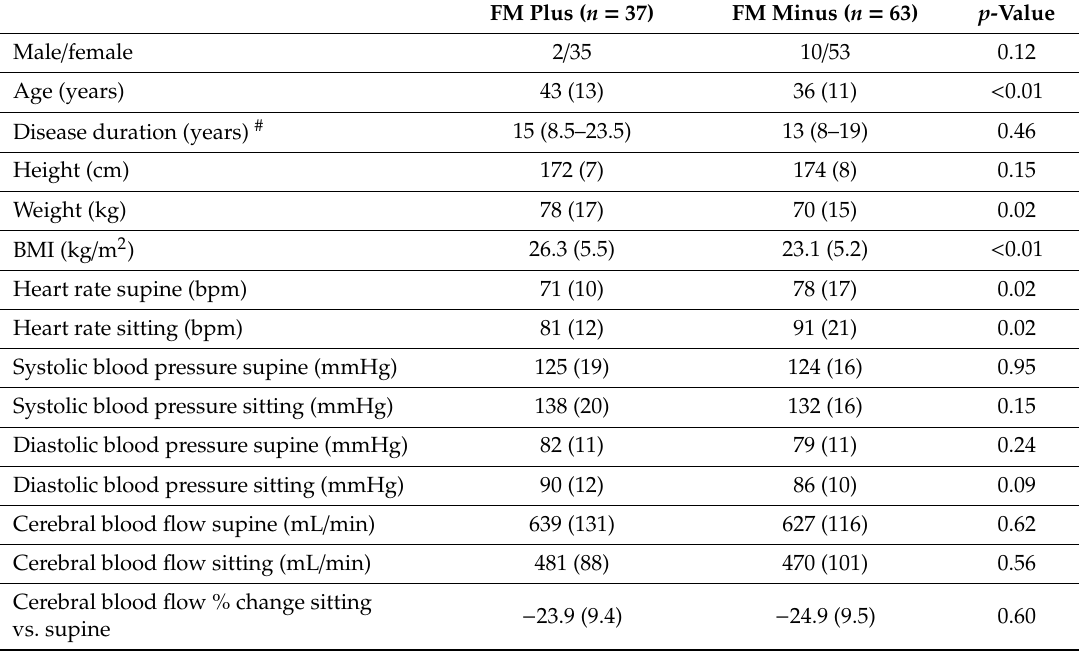
Table 3. Baseline and orthostatic stress test results in severe ME / CFS patients with fibromyalgia ( n = 37) and in severe ME / CFS patients without fibromyalgia ( n = 63).